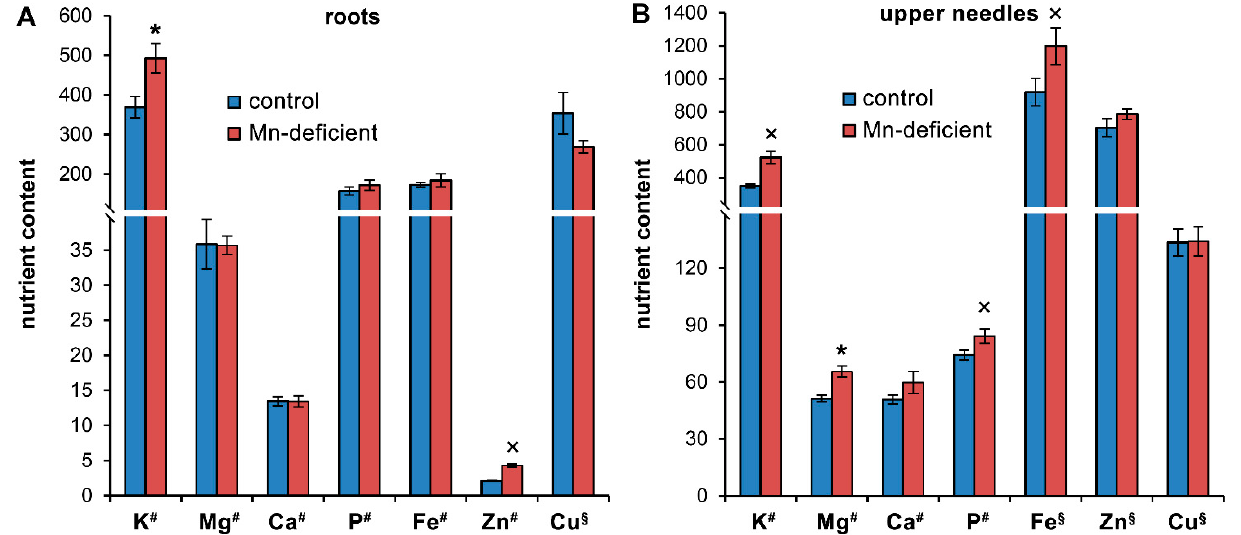
Figure 3. The contents of nutrients in the organs of Scots pine seedlings at the 24th week of the experiment: roots ( A ); upper needles ( B ). The mean values ± SEs are given ( n = 6). The mean element contents in µmol/g DW (#) or nmol/g DW (§). Asterisks (*, for Student’s t test) or multiplication signs (×, for Mann–Whitney rank sum test) denote significant differences at p < 0.05 between control and Mn-deficient plants.